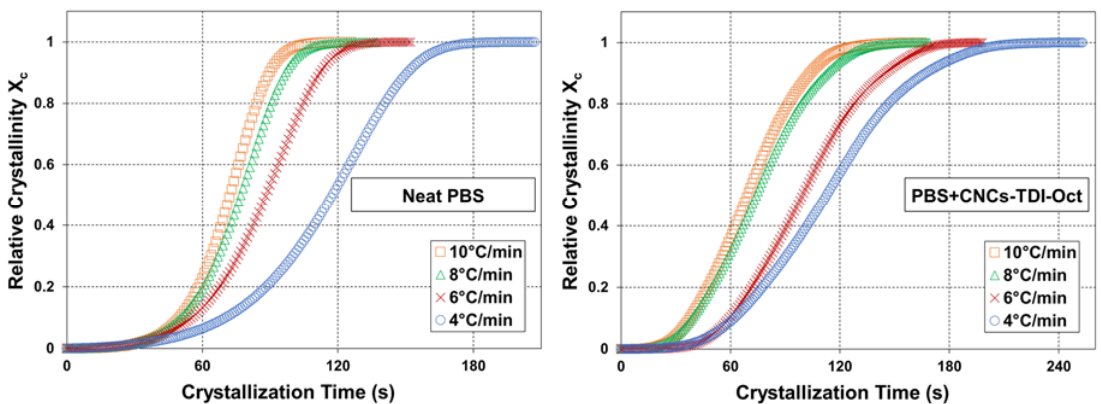
Figure 4. Plots of relative crystallinity with time at different cooling rates for neat PBS (left) and PBS+CNCs ‐ TDI ‐ Oct (right).